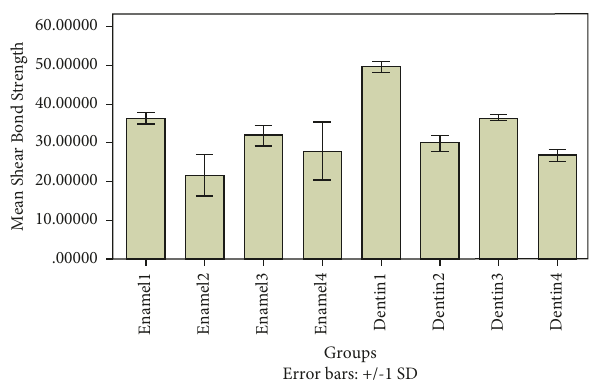
Figure 1: Comparison of mean shear bond strengths of various groups.